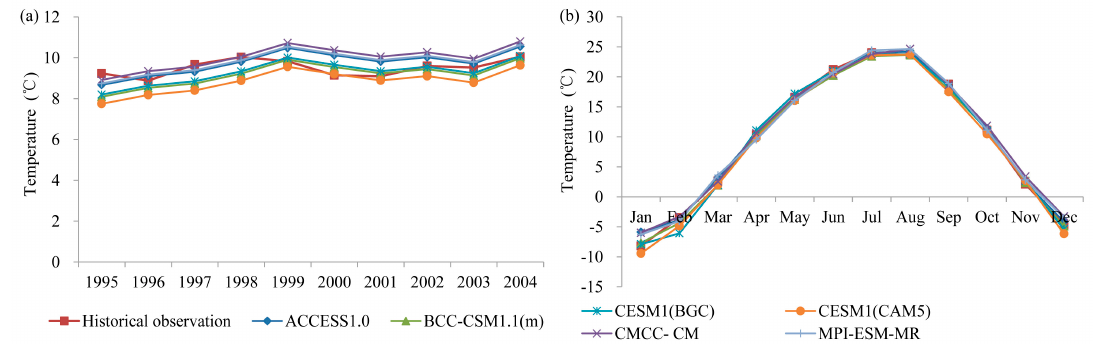
Figure 4. Comparison of the average downscaled temperature from CMIP5 using morphing and historical observation temperature series: ( a ) annual series; ( b ) monthly distribution.